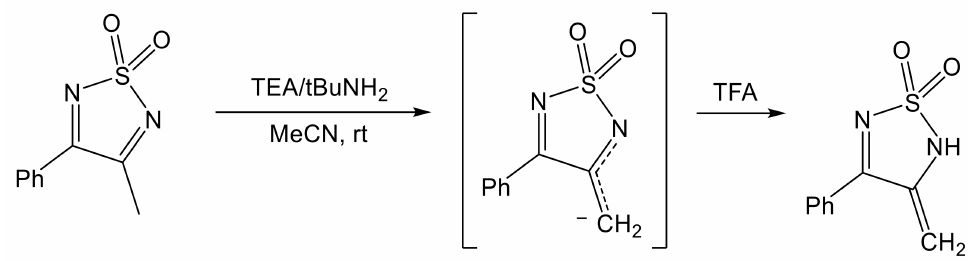
Figure 9. Abstraction of proton from methyl group of 3-methyl-4-phenyl 1,2,5-thiadiazole 1,1-dioxide with the formation of tautomeric carbanion followed by the separation of a 3-methylene-4-phenyl- 2,3-dihydro-1,2,5-thiadiazole 1,1-dioxide by the addition of strong acid [93].